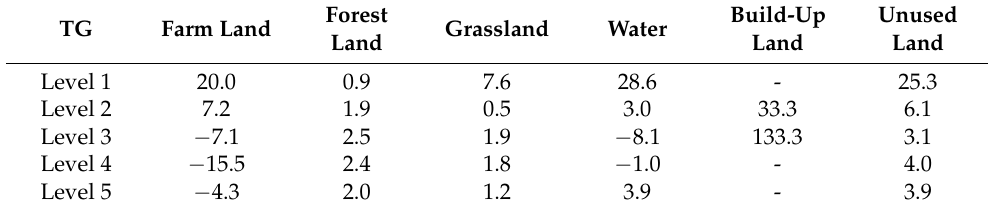
Table 1. Variation in ecosystem based on terrain gradient from 1990 to 2015 (%).